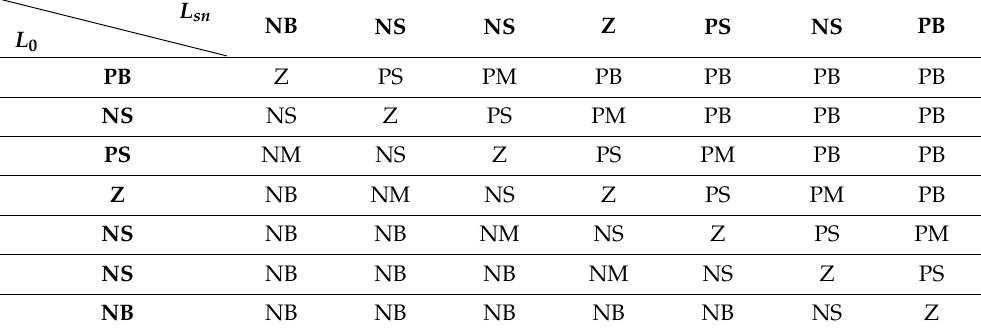
Figure 1. ( a ) Triangular Input and ( b ) Singleton CoG based Output membership functions. In the above figure, L sn and L 0 are defined as input error and rate of change of input error respectively. The rules are mentioned in Table 2. Table 2. Rules for Vectoral